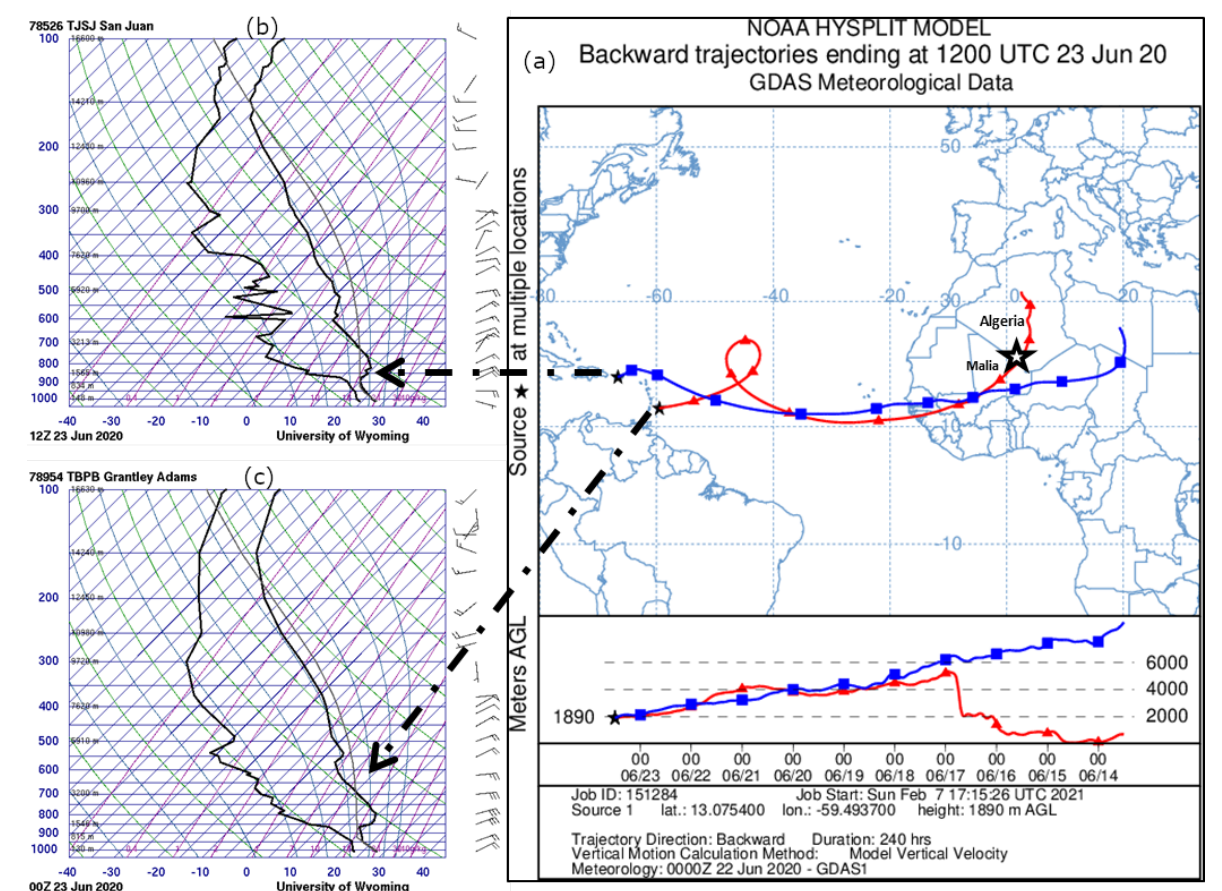
Figure 12. ( a ) NOAA HYSPLIT 10-day backward trajectories ending at San Juan (PR) and Grantley Adams (BAR) on 23 June 2020. The corresponding soundings from Wyoming are depicted in subfigure ( b ) for San Juan (PR) and subfigure ( c ) Grantley Adams